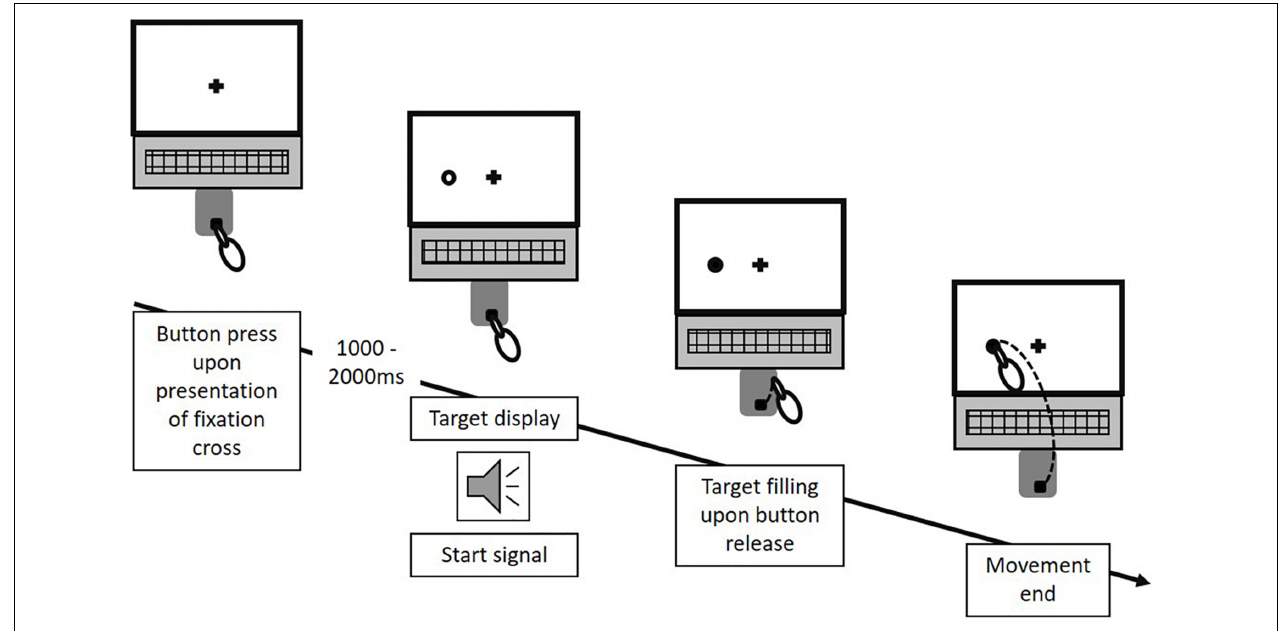
FIGURE 2 | Experimental procedure. In each trial, following a random waiting period of 1–2 s after an initial button press, the potential reach targets were displayed as unfilled circles, appearing at any of the three potential target locations surrounding the fixation cross. Simultaneously, an acoustic start signal triggered participant’s response. Upon button release, the final reach target was indicated through filling of the respective circle. Each trial ended with participants touching a circle on the screen. This figure exemplifies the procedure for one potential trial of Condition A. The same temporal procedure applied for Condition B and C. However, for Condition B and C, two circles were displayed at any of the three location-combinations in each